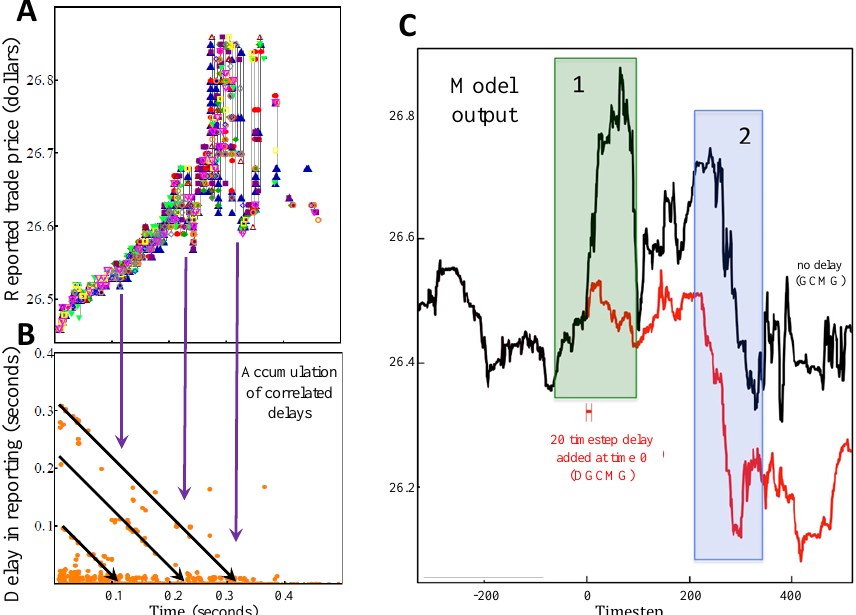
Figure 8. ( A ) The network of networks of U.S. electronic exchanges produces multiple examples of sub-second extreme behavior. In this example, the data-points show trades (i.e., prices of trade events) for Suncor stock within a 500 millisecond (i.e., 0.5 s) time interval. Each color corresponds to a different electronic exchange network within the larger network of U.S. exchange networks. They are physically interconnected by communications channels. Data was kindly provided by NANEX; ( B ) Orange dots show the delay τ (vertical axis) between the time at which a particular trade event was reported system-wide and the time at which it actually occurred in a particular network exchange (which is shown on the horizontal axis). These delays predate the intentional 350 microsecond delay added in 2016 [13], however the fact that they show such strong temporal correlations demonstrates the possible effect of such an intentional (and hence highly temporally correlated) delay. The parallel diagonal lines show the shockwaves of successive trades eventually getting reported system-wide. The fact that these waves of system-wide reporting occur a few milliseconds ahead of significant dynamical features in panel A, is likely due to each reporting shockwave driving the networks’ trading algorithms (i.e., agents) to produce a sudden change in aggregate supply and demand, which the appears a few milliseconds later as a new dynamical feature in panel A; ( C ) DGCMG system output (red line) showing the price x ( t ) over time following a small delay τ = 20 introduced at t 0 = 0. Black line shows same system but with no delay, i.e., GCMG. Window 2 shows a future extreme behavior akin to panel A that still occurs with the delay, while window 1 shows a future extreme behavior that effectively disappears when the delay is